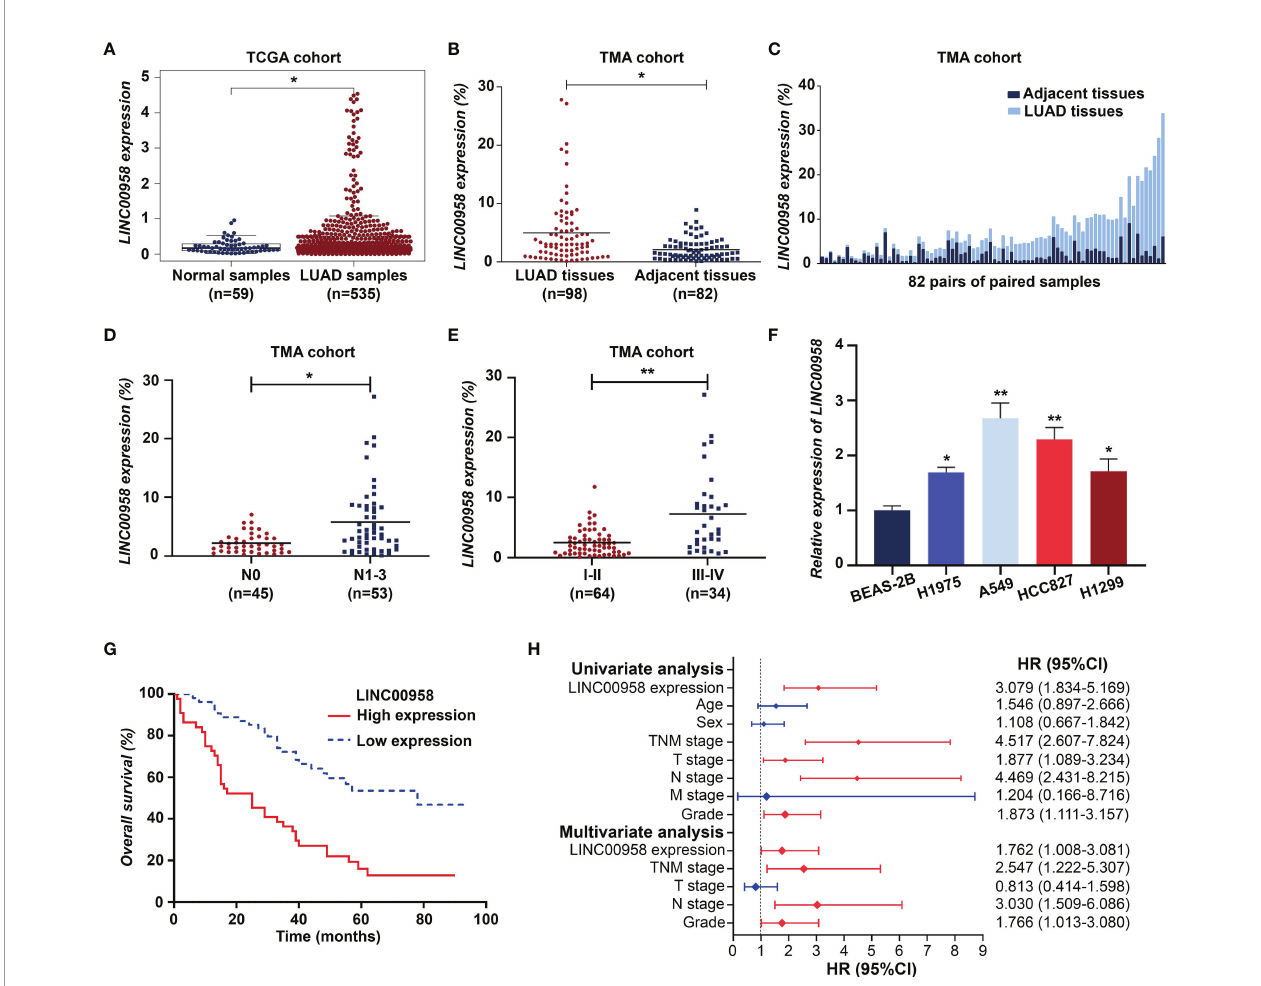
FIGURE 1 | LINC00958 expression is upregulated in patients with lung adenocarcinoma (LUAD) and correlated with poor prognosis. (A) The expression of LINC00958 in the LUAD cohort obtained from The Cancer Genome Atlas database. (B) Fluorescent in situ hybridization (FISH) analysis of tissue microarray demonstrated that the expression of LINC00958 in LUAD tissues was upregulated when compared with that in the adjacent non-tumorous tissues. (C) FISH analysis of LINC00958 expression in 82 pairs of LUAD and adjacent non-tumorous tissues. (D) The correlation between LINC00958 expression and lymph node metastasis in patients with LUAD. (E) The correlation between LINC00958 expression and TNM staging in patients with LUAD. (F) The expression level of LINC00958 in LUAD cell lines. (G) Kaplan-Meier survival analysis according to the LINC00958 expression levels in 98 patients with LUAD. (H) Univariate Cox regression and multivariate analyses revealed that LINC00958 is an independent prognostic factor for LUAD. * P < 0.05 and ** P <